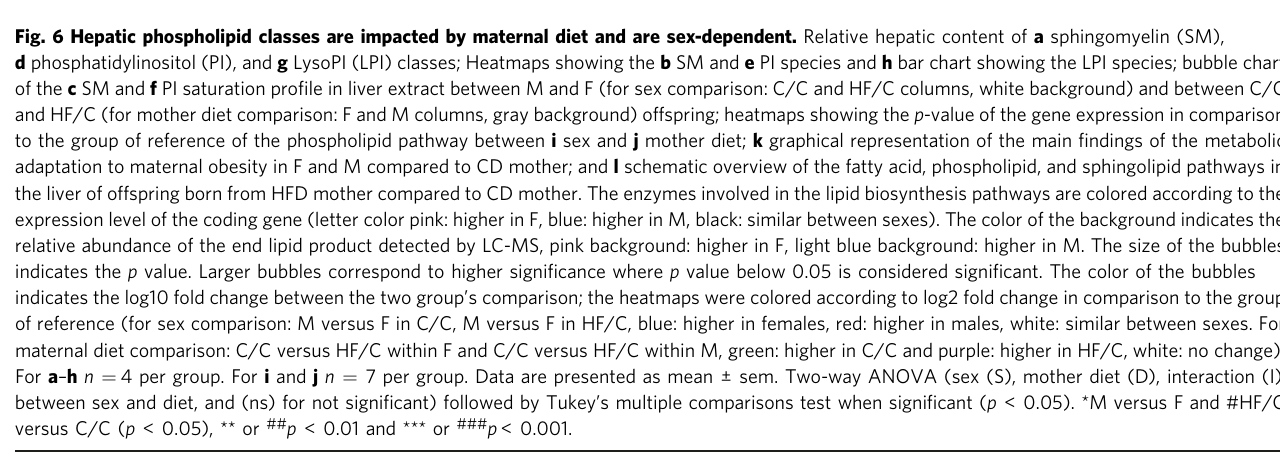
Fig. 6 Hepatic phospholipid classes are impacted by maternal diet and are sex-dependent. Relative hepatic content of a sphingomyelin (SM), d phosphatidylinositol (PI), and g LysoPI (LPI) classes; Heatmaps showing the b SM and e PI species and h bar chart showing the LPI species; bubble chart of the c SM and f PI saturation pro fi le in liver extract between M and F (for sex comparison: C/C and HF/C columns, white background) and between C/C and HF/C (for mother diet comparison: F and M columns, gray background) offspring; heatmaps showing the p -value of the gene expression in comparison to the group of reference of the phospholipid pathway between i sex and j mother diet; k graphical representation of the main fi ndings of the metabolic adaptation to maternal obesity in F and M compared to CD mother; and l schematic overview of the fatty acid, phospholipid, and sphingolipid pathways in the liver of offspring born from HFD mother compared to CD mother. The enzymes involved in the lipid biosynthesis pathways are colored according to the expression level of the coding gene (letter color pink: higher in F, blue: higher in M, black: similar between sexes). The color of the background indicates the relative abundance of the end lipid product detected by LC-MS, pink background: higher in F, light blue background: higher in M. The size of the bubbles indicates the p value. Larger bubbles correspond to higher signi fi cance where p value below 0.05 is considered signi fi cant. The color of the bubbles indicates the log10 fold change between the two group ’ s comparison; the heatmaps were colored according to log2 fold change in comparison to the group of reference (for sex comparison: M versus F in C/C, M versus F in HF/C, blue: higher in females, red: higher in males, white: similar between sexes. For maternal diet comparison: C/C versus HF/C within F and C/C versus HF/C within M, green: higher in C/C and purple: higher in HF/C, white: no change). between sex and diet, and (ns) for not signi fi cant) followed by Tukey ’ s multiple comparisons test when signi fi cant ( p < 0.05). *M versus F and #HF/C versus C/C ( p < 0.05), ** or ## p < 0.01 and *** or ### p